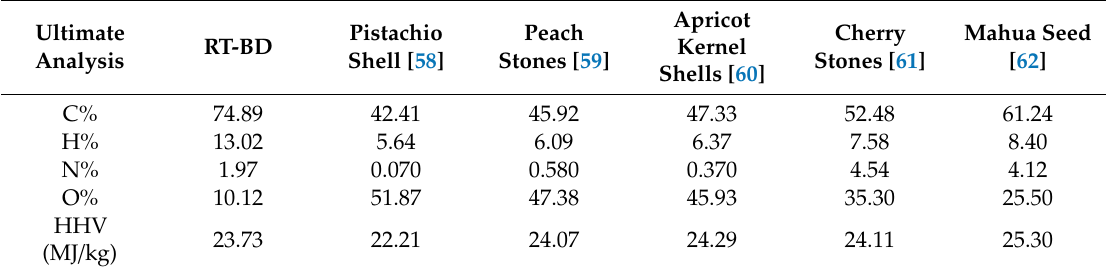
RTBD EA (Elemental Analyser) analysis in comparison with other plant seed and shells